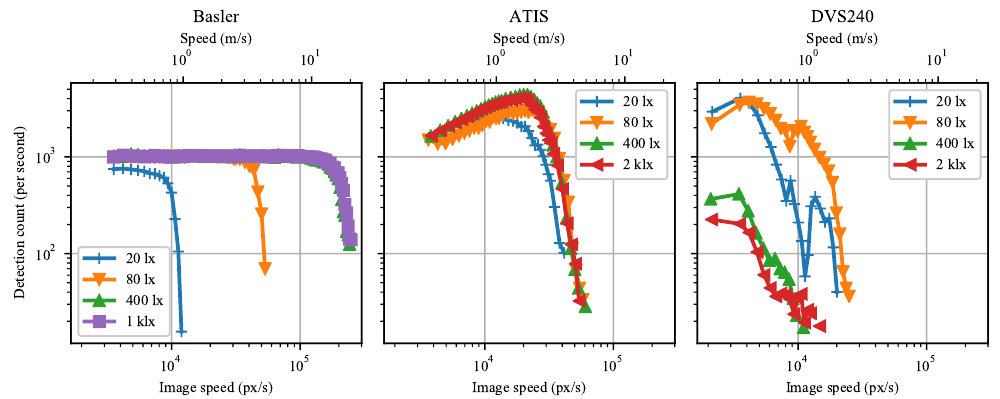
Figure 11. Mean number of marker detections per second as a function of marker speed for Basler, ATIS, and DVS240 cameras. Data were measured for four background scene illuminance levels at the sensor plane.